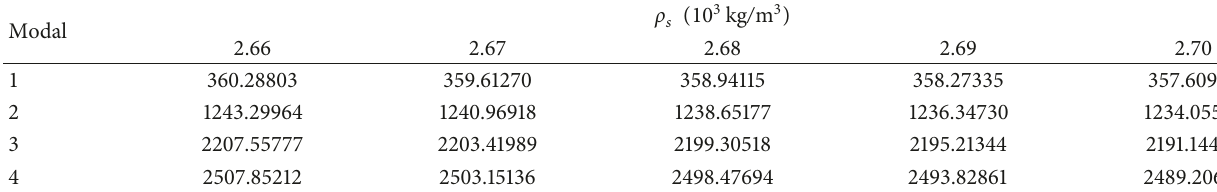
Table 2: Frequencies of different material densities of honeycomb sandwich plate.